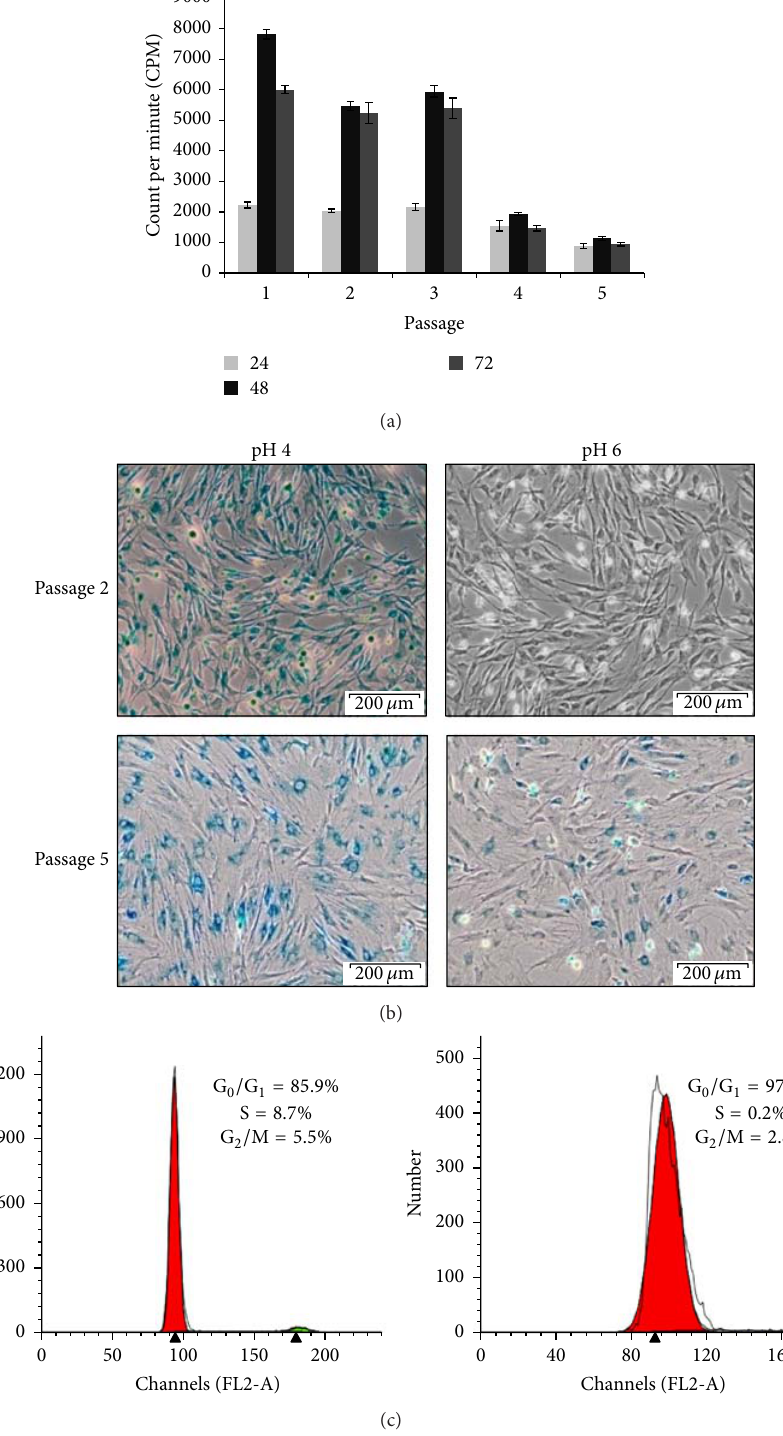
Figure 4: Cellular senescence and cell cycle arrest of culture expanded rBM-MSCs. Cells from passages 1–5 were seeded at 5000 cells/well cultured in 96-well plate for 24 h, 48 h, and 72 h. Cultures were pulsed with 10 𝜇 L 3 H-TdR at 24 hours prior to measurement. The rate of proliferation decreased as the passage increased (a). Cells at passage 2 and passage 5 were fixed with 70% ethanol for 10 minutes and stained with X-gal in the respective buffer overnight. Cells at passages 2 and 5 were stained positive with lysosomal 𝛽 -gal (pH 4) staining showing that cells were expressing lysosomal 𝛽 -gal in early passage as well as in late passage. Cells at passage 5 were stained positive for SA- 𝛽 -gal (pH 6) staining as evidenced by blue precipitation but not at passage 2. Cells at passage 2 and passage 5 were cultured in 25 cm 2 flasks. Upon reaching 80%–90% confluency, cells were harvested and subjected to PI staining. Cells were analysed using flow cytometer. Results were representative of three independent experiments. Microscopic magnification: